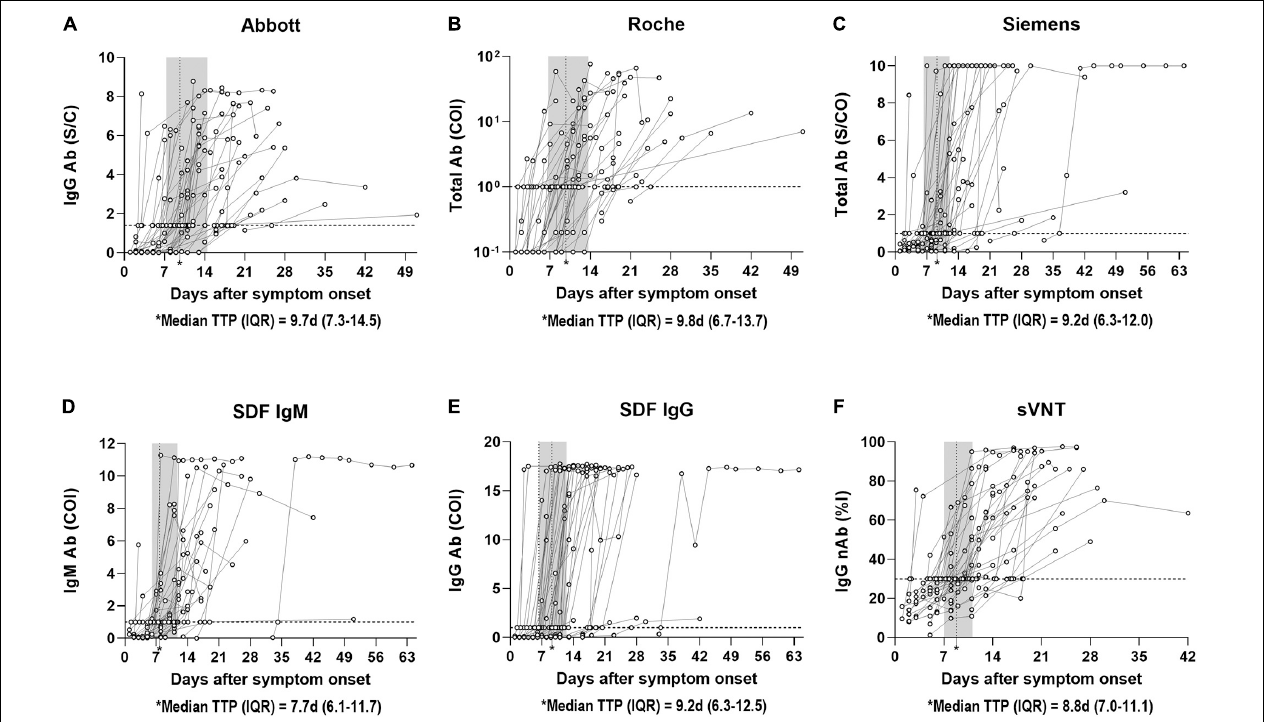
FIGURE 2 | Distribution of time to seropositivity (TTP) of SARS-CoV-2 antibody immunoassays. (A) TTP of Abbott IgG antibody in 135 samples from 44 patients with PCR positive COVID-19 according to days post symptom onset. (B) TTP of Roche Total antibody in 121 samples from 41 patients with PCR positive COVID-19 according to days post symptom onset. (C) TTP of Siemens Total antibody in 132 samples from 39 patients with PCR positive COVID-19 according to days post symptom onset. (D) TTP of SDF IgM antibody in 125 samples from 37 patients with PCR positive COVID-19 according to days post symptom onset. (E) TTP of SDF IgG antibody in 139 samples from 42 patients with PCR positive COVID-19 according to days post symptom onset. (F) TTP of sVNT IgG neutralizing antibody in 133 samples from 41 patients with PCR positive COVID-19 according to days post symptom onset. The horizontal dotted line indicates the cut-off ratio for positivity. The vertical dotted line in the shaded area represents the median TTP with interquartile range. Each curve indicates the non-linear sigmoidal fit of circles of each patient. TTP is calculated by interpolating the positive cut-off line to the curve based on the four-parameter logistic (4PL) equation. Abbott, SARS-CoV-2 IgG (Abbott); Ab, antibody; COI, cut-off index; d, days; IQR, interquartile range; nAb, neutralizing antibody; %I, percentage inhibition; Roche, Elecsys Anti-SARS-CoV-2 (Roche); S/C, sample/calibrator; S/CO, sample/cut-off; SDF, STANDARD F COVID-19 IgM/IgG Combo FIA (SD BIOSENSOR); Siemens, ADVIA Centaur SARS-CoV-2 Total (Siemens); sVNT, surrogate virus neutralization